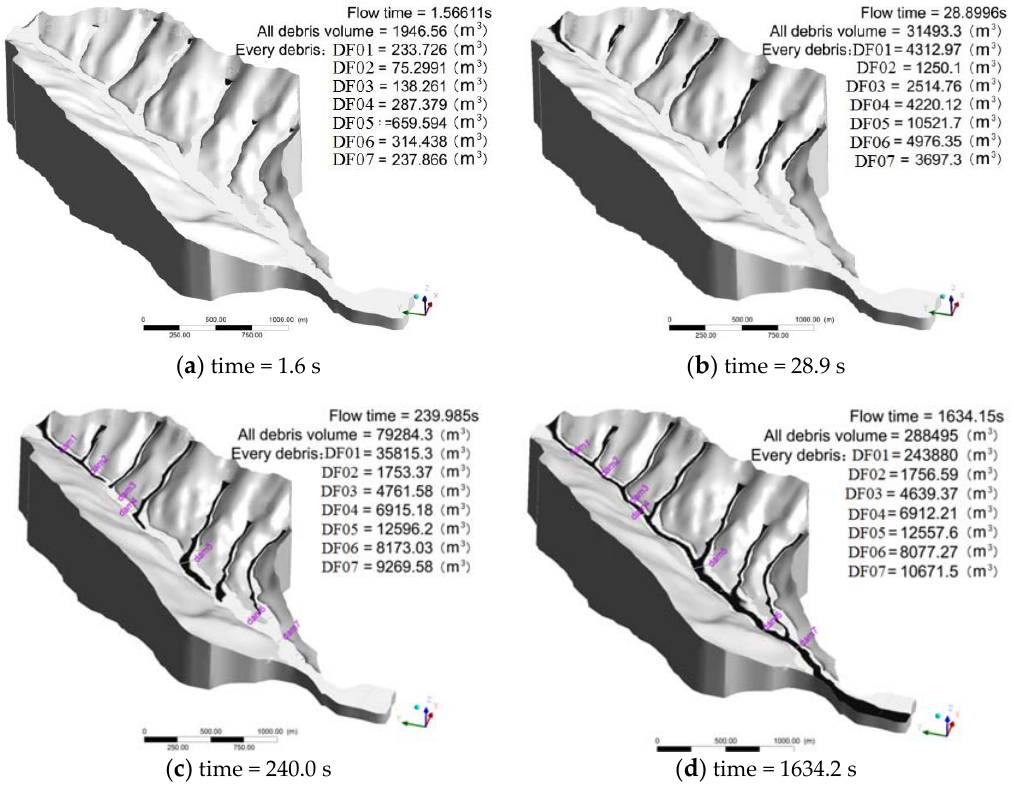
Figure 6. Simulation of the debris flow state.